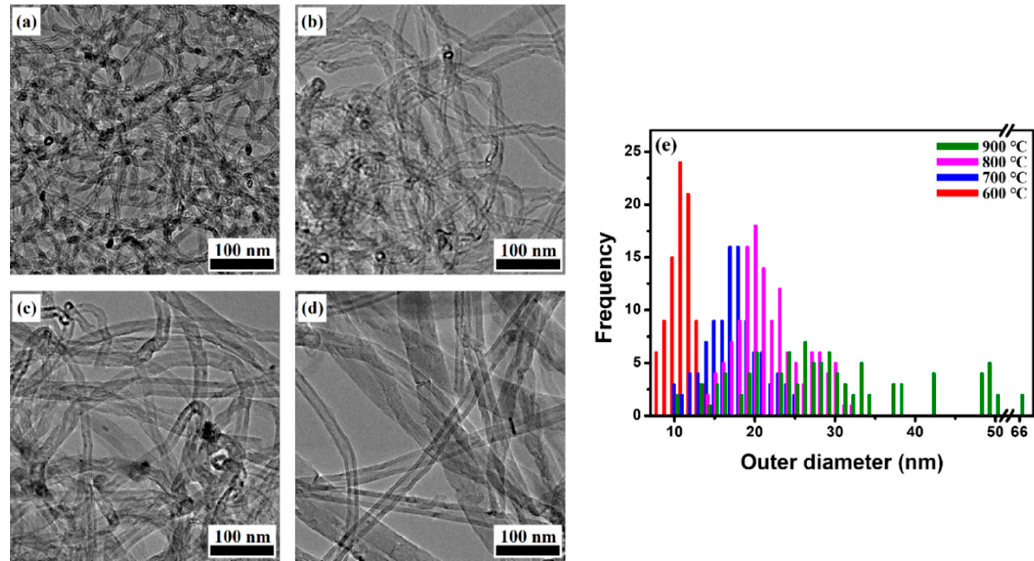
Figure 5. TEM image of the as-synthesized MWNCTs using catalysts reduced at ( a ) 600, ( b ) 700, ( c ) 800, and ( d ) 900 °C; ( e ) for histograms of diameter distributions.